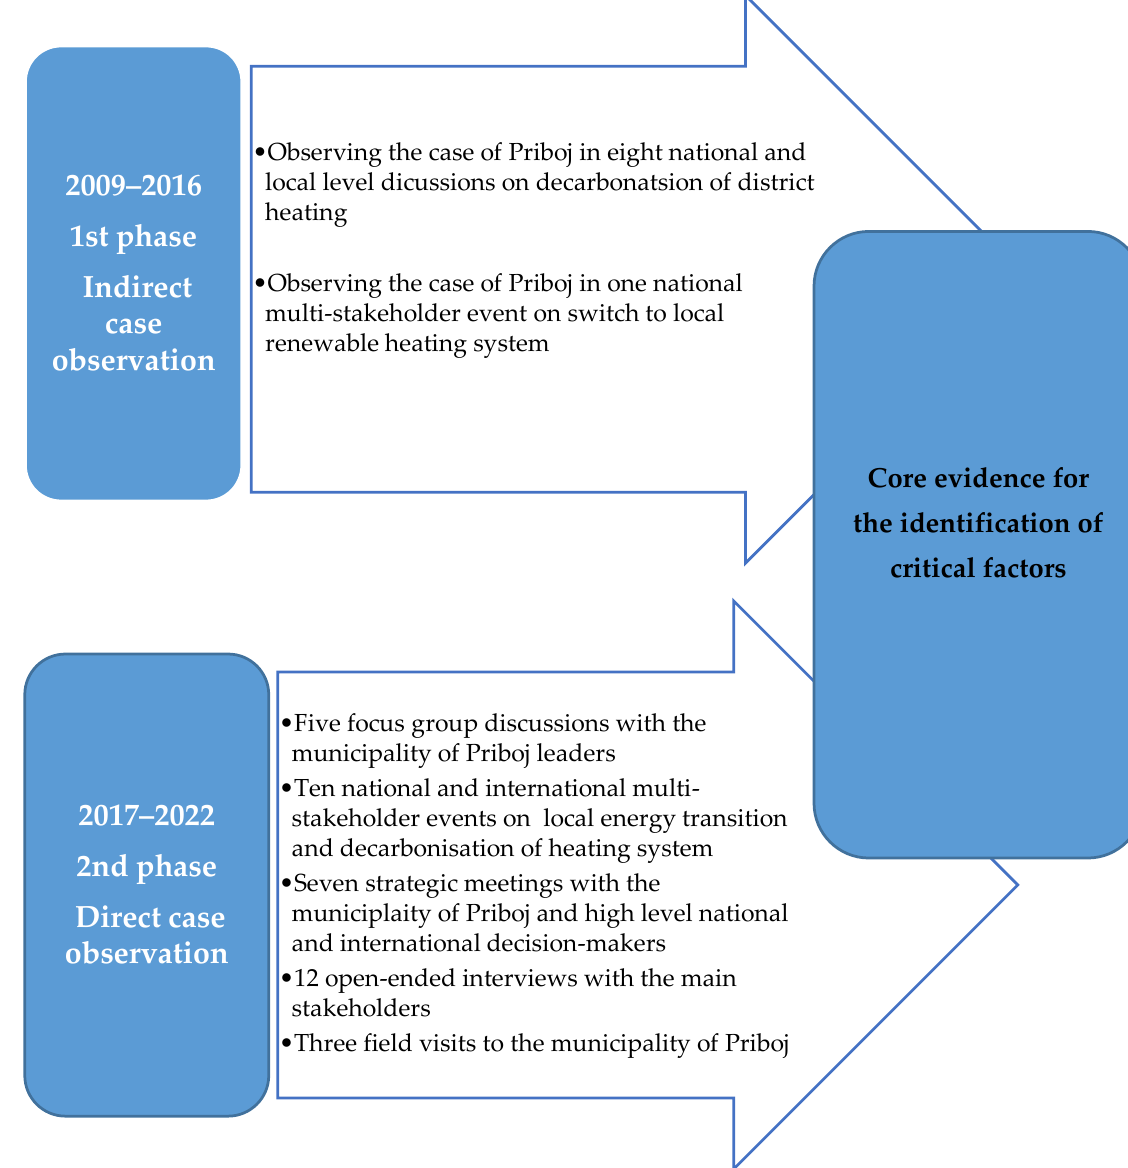
Figure 3. Two major stages of the case observation that provides the core evidence for the identification of critical factors in local energy transition through the lenses outlined in the operational framework.